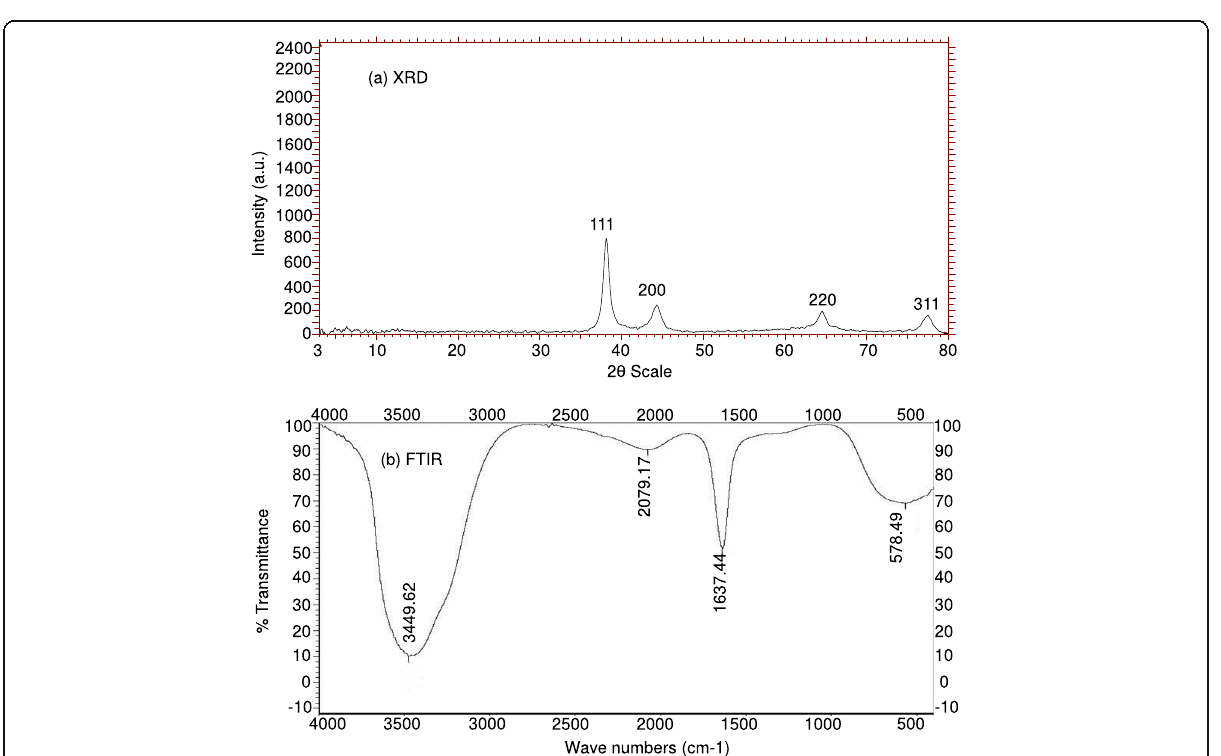
Fig. 3 Characterization of AM-AuNPs ( a ) XRD pattern of biogenic gold nanoparticles synthesized using A. mexicana plant extract. b FTIR spectrum gold nanoparticles synthesized using aqueous extract of A. mexicana